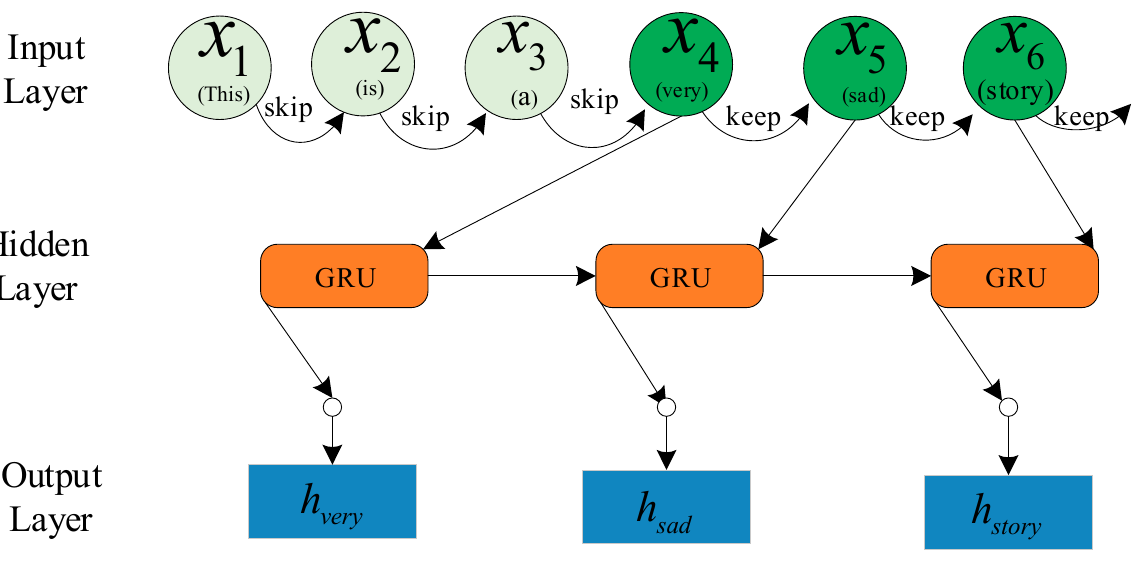
Figure 2. Skip-GRU model.